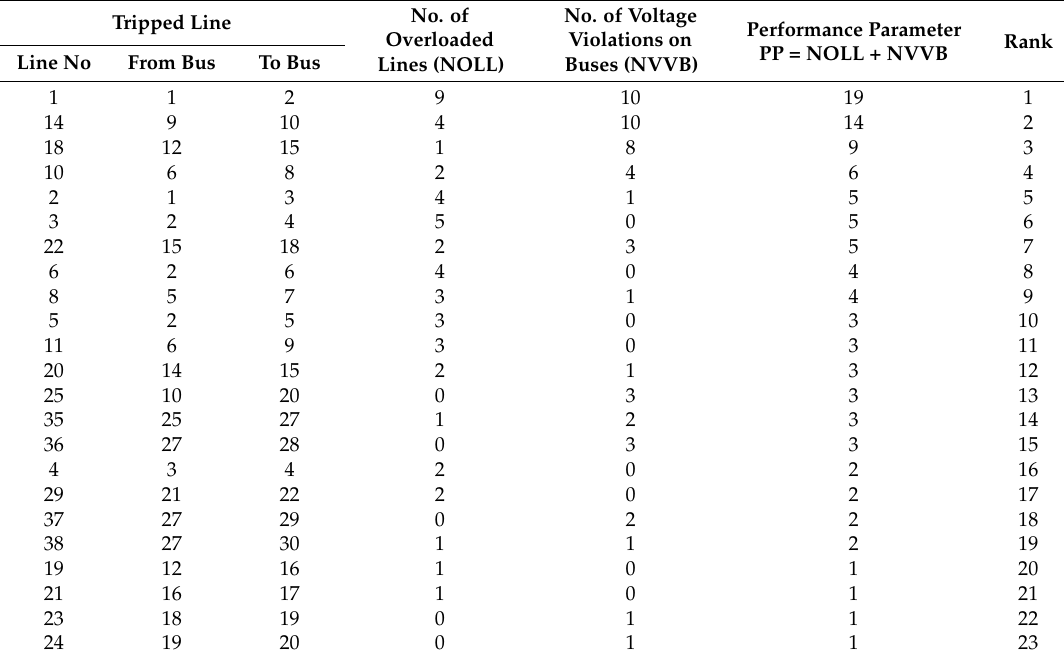
Table 7. Contingency Analysis with Performance Parameter and Ranking